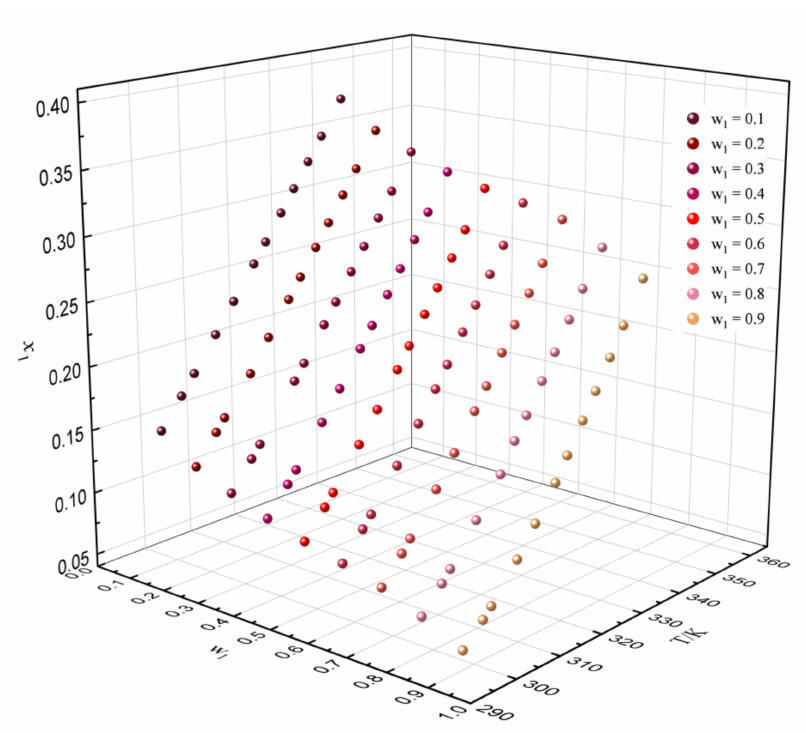
Figure 9. Solubility prediction data of dehydroabietic acid in the binary solvent of ( − )- α -pinene (w 1 ) + p-cymene with various mass fractions at different temperatures.